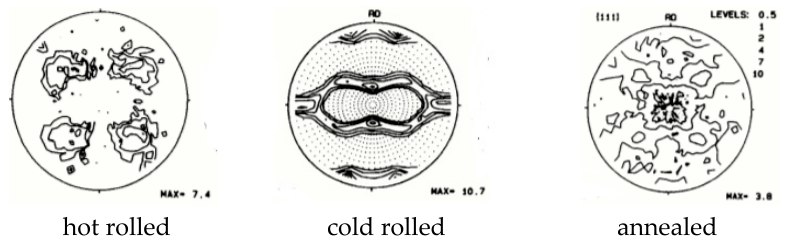
Figure 4. Typical textures [(111) pole figures] in di ff erent processing stages of Al-alloy sheet